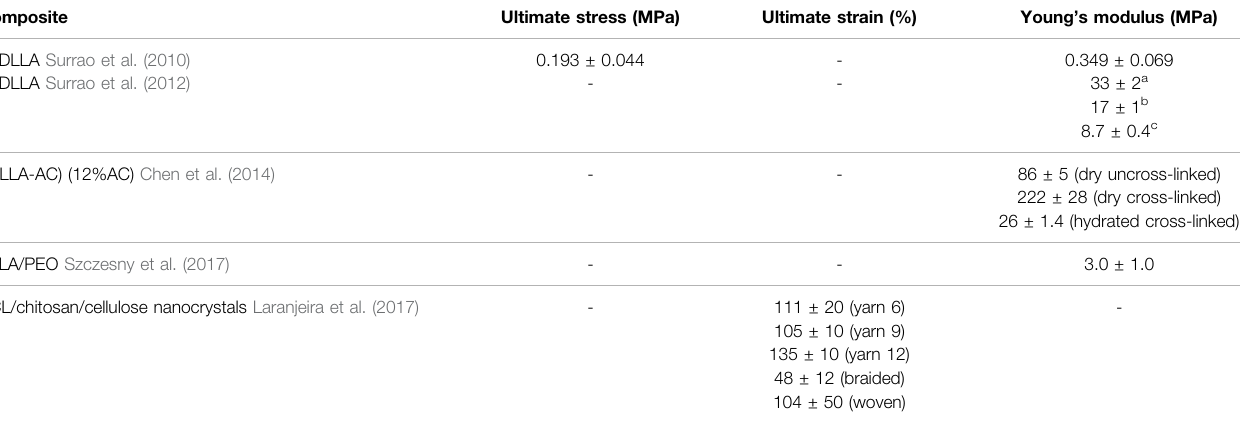
TABLE 2 | Summary of mechanical properties of crimped fi bers in